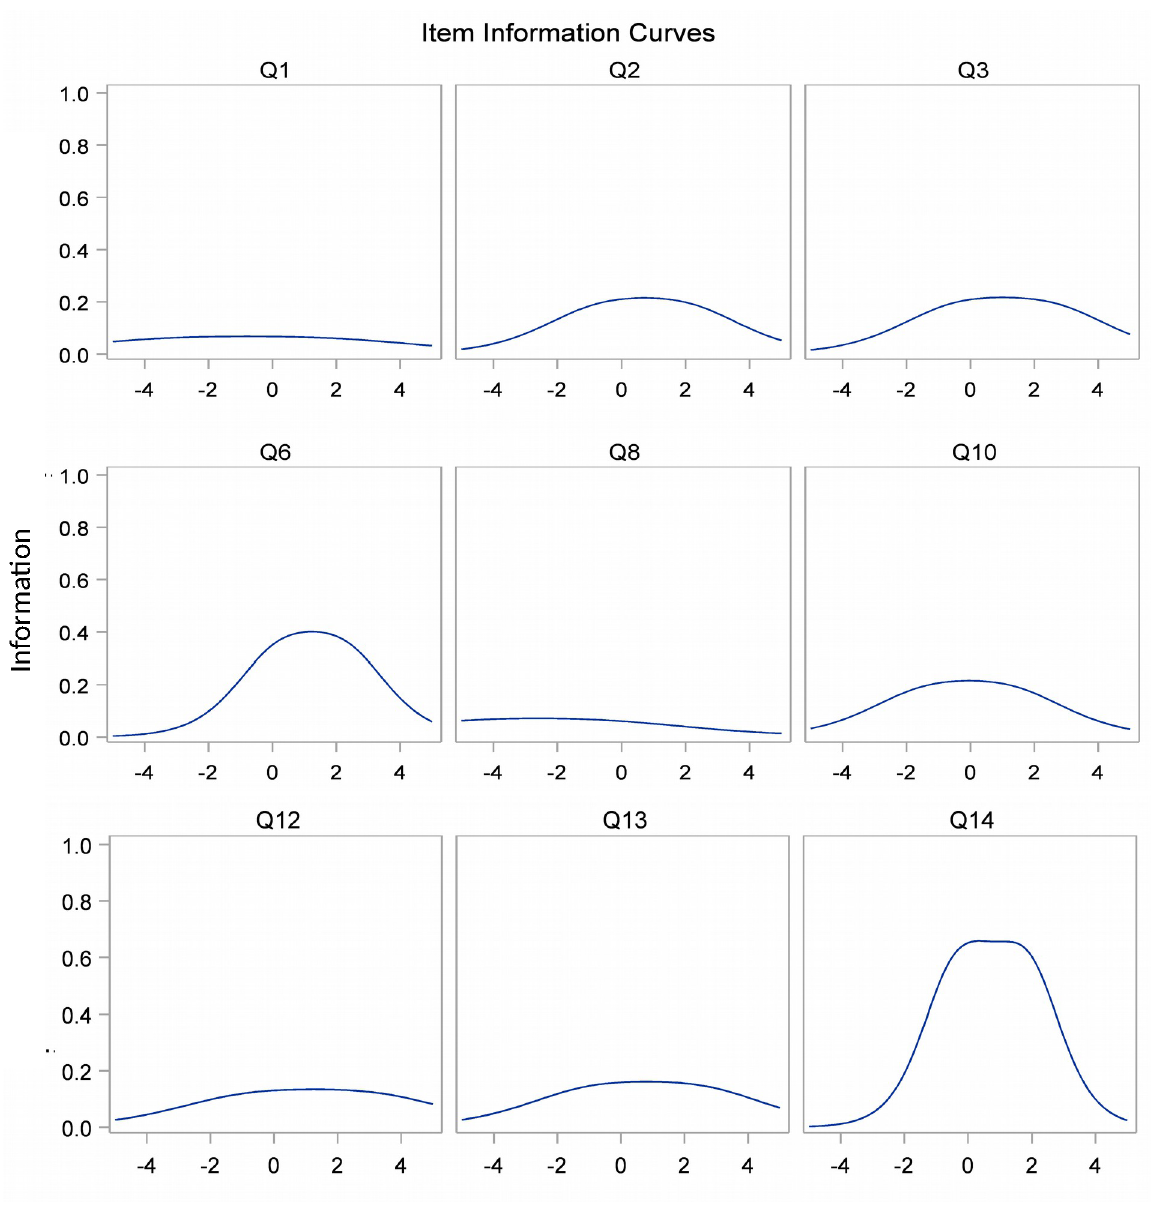
Fig 4. Item information curves of the nine items used for scoring the BBQ scale obtained by the parametricIRT model. Items 1, 8, 12 and 13 have a low power of information over the entire scale. These items contributedvery little to the ranking of individuals. Conversely,the strongest informationspower were observed for items 6 and 14. The minimalanonymizeddata set of the present study is availablein S2 Appendix.